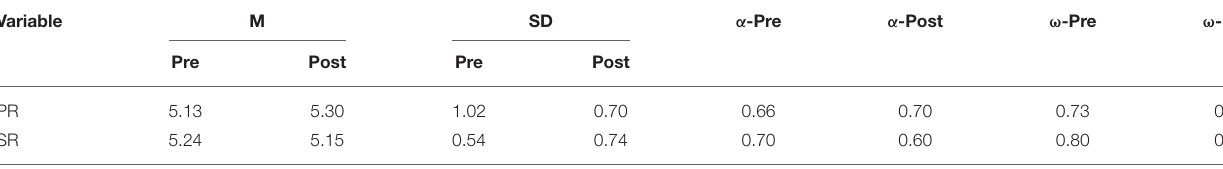
TABLE 7 | Descriptive statistics and reliability analysis.